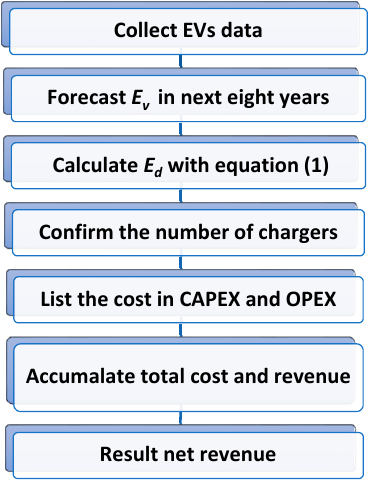
Figure 16. The process of net revenue calculation.